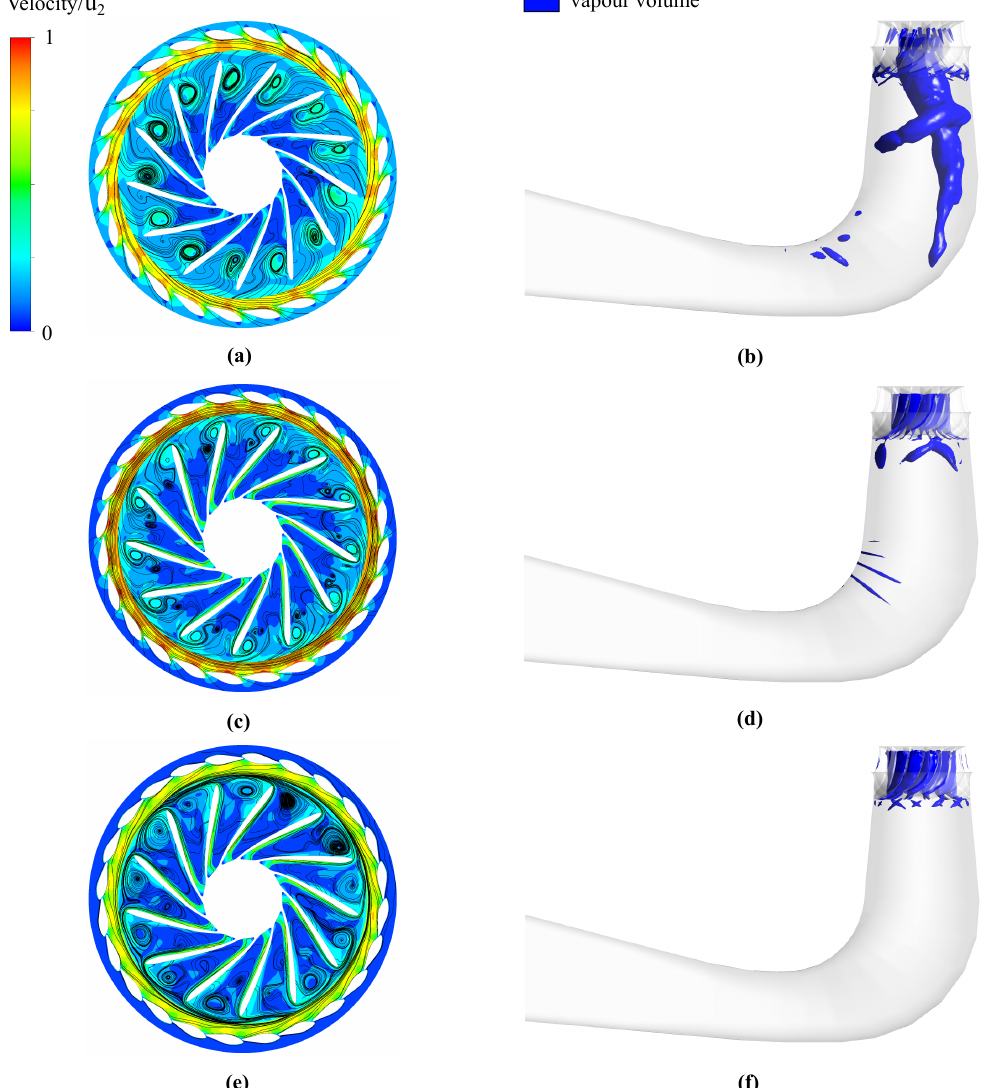
Figure 8. Flow field at the initial state ( a ) in the runner channel and ( b ) vortex structures in the draft tube. Flow field after 9 s ( c ) in the runner channel and ( d ) vortex structures in the draft tube. Flow field after 20 s ( e ) in the runner channel and ( f ) vortex structures in the draft